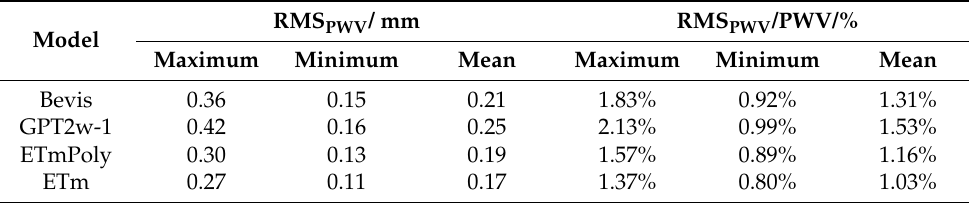
Table 4. Statistical results of RMS PWV and RMS PWV /PWV in 2021 using 60 radiosonde stations over